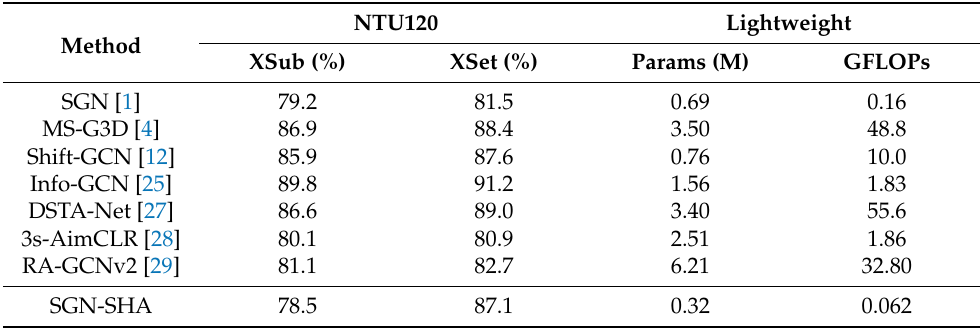
Table 2. Accuracy, numbers of parameters, and computation complexity between SoTA methods and the proposed method on the NTU120